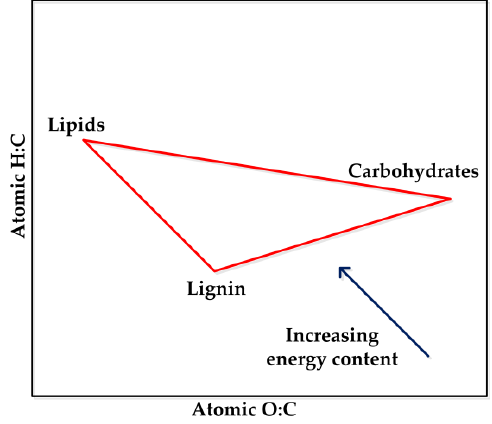
Figure 2. Elemental Composition of Biomass (van Krevelen plot) [32] – Reproduced by permission of The Royal Society of Chemistry.